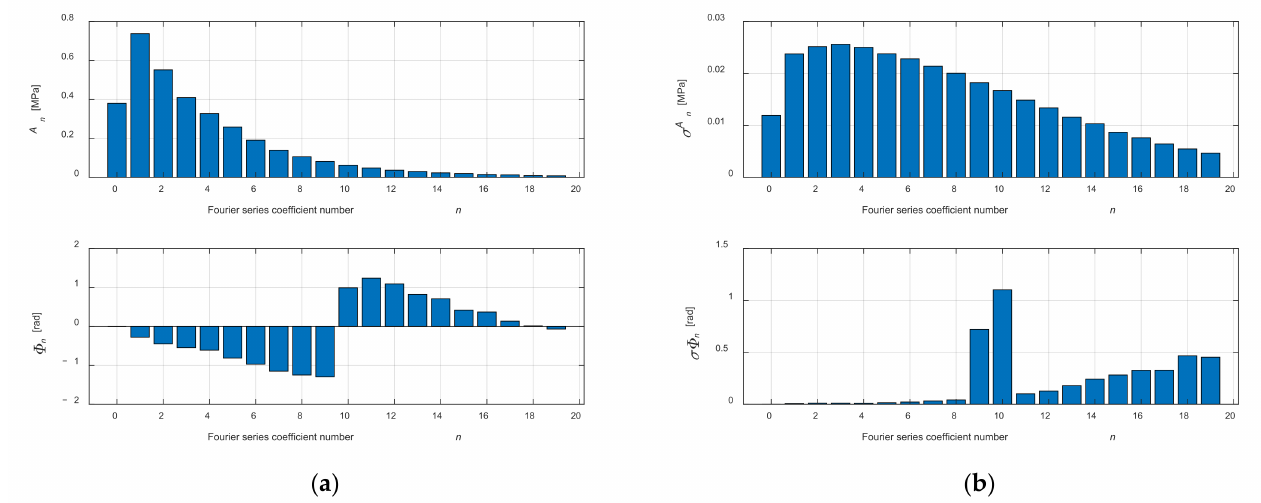
Figure 11. Determined coefficients A n and Φ n of a Fourier series after averaging ( a ) and determined values of standard deviations σ A n and σΦ n ( b ) for 100 consecutive